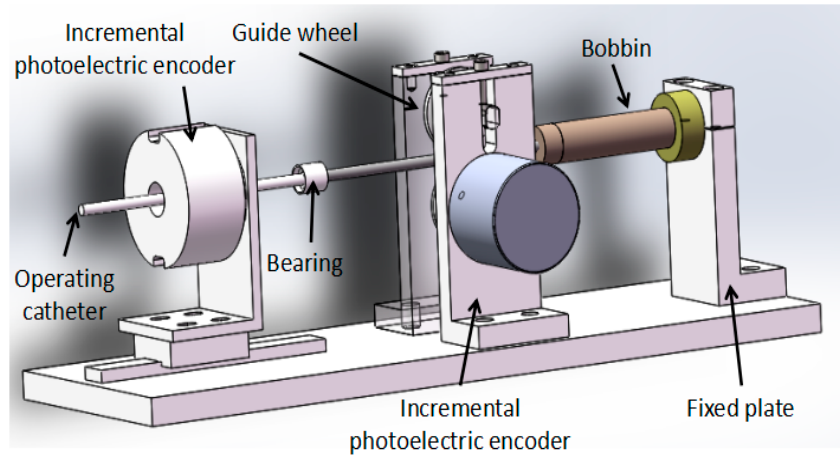
Figure 2. The structure of the master manipulator.